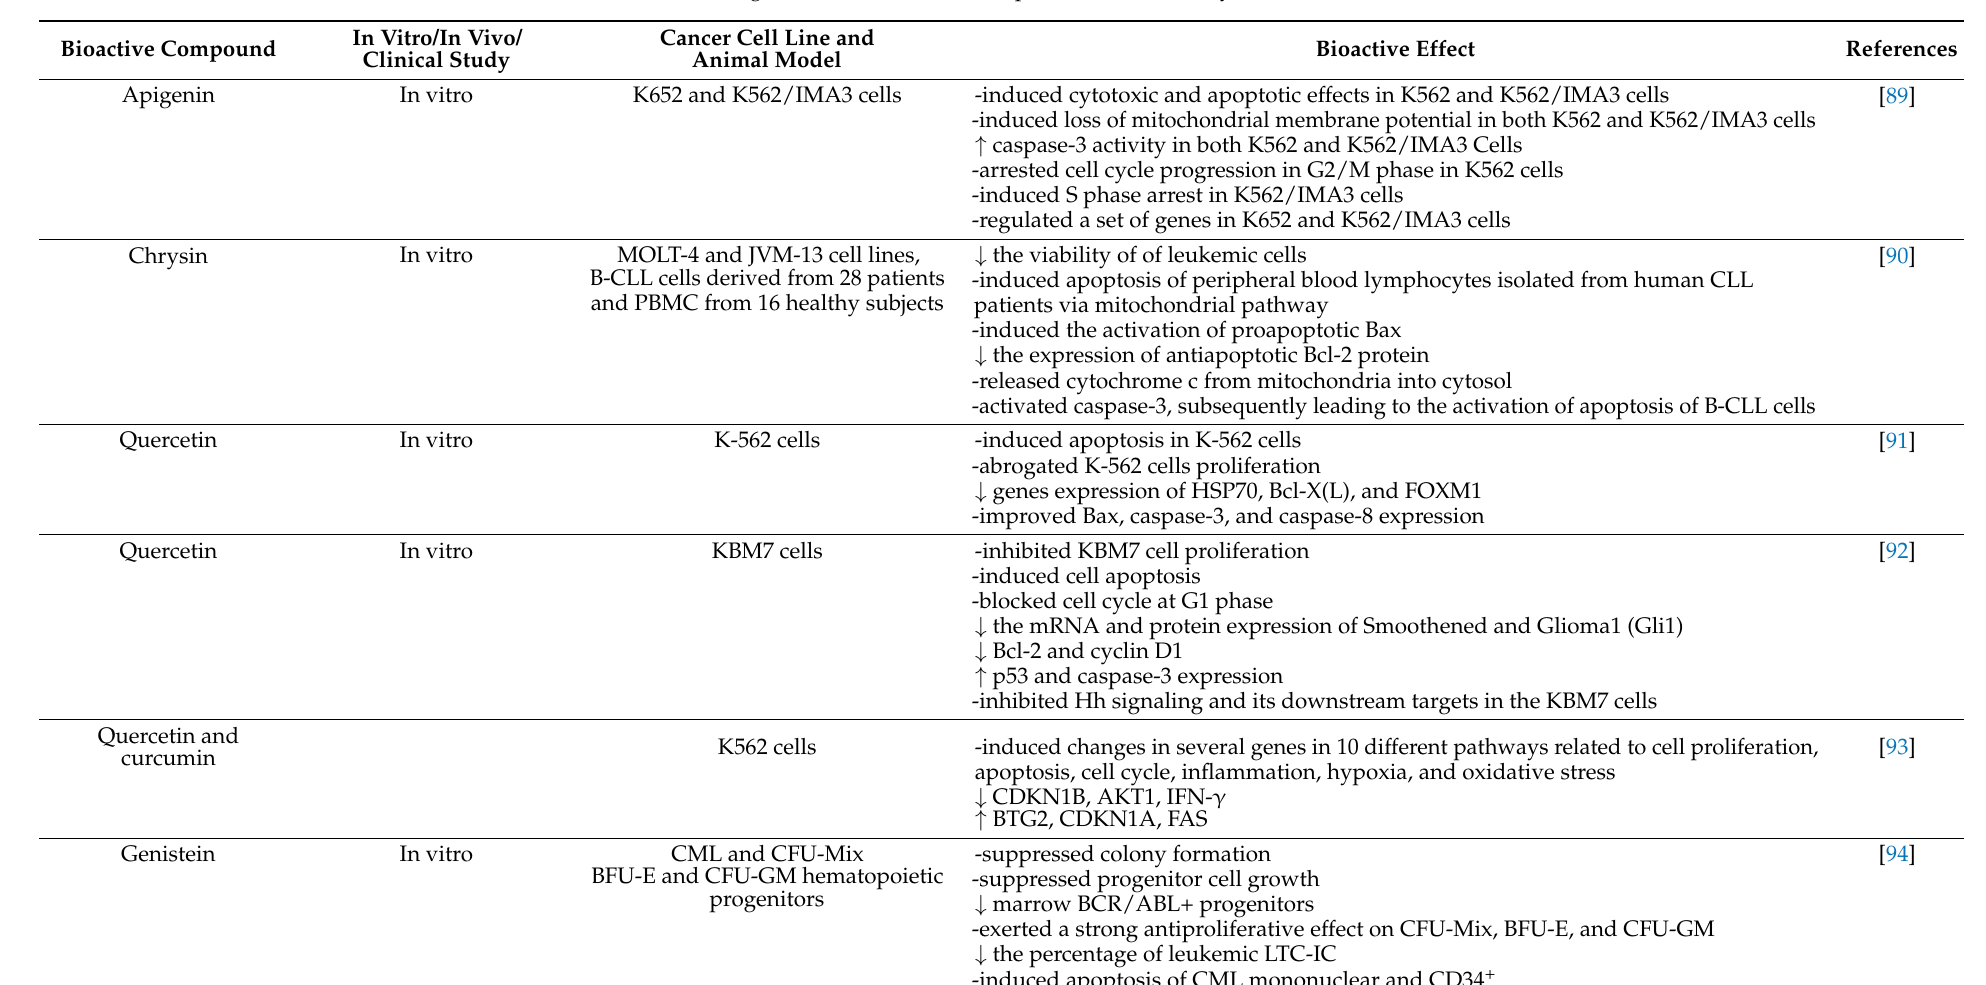
Table 2. Pharmacological effects of natural compounds in chronic myeloid leukemia